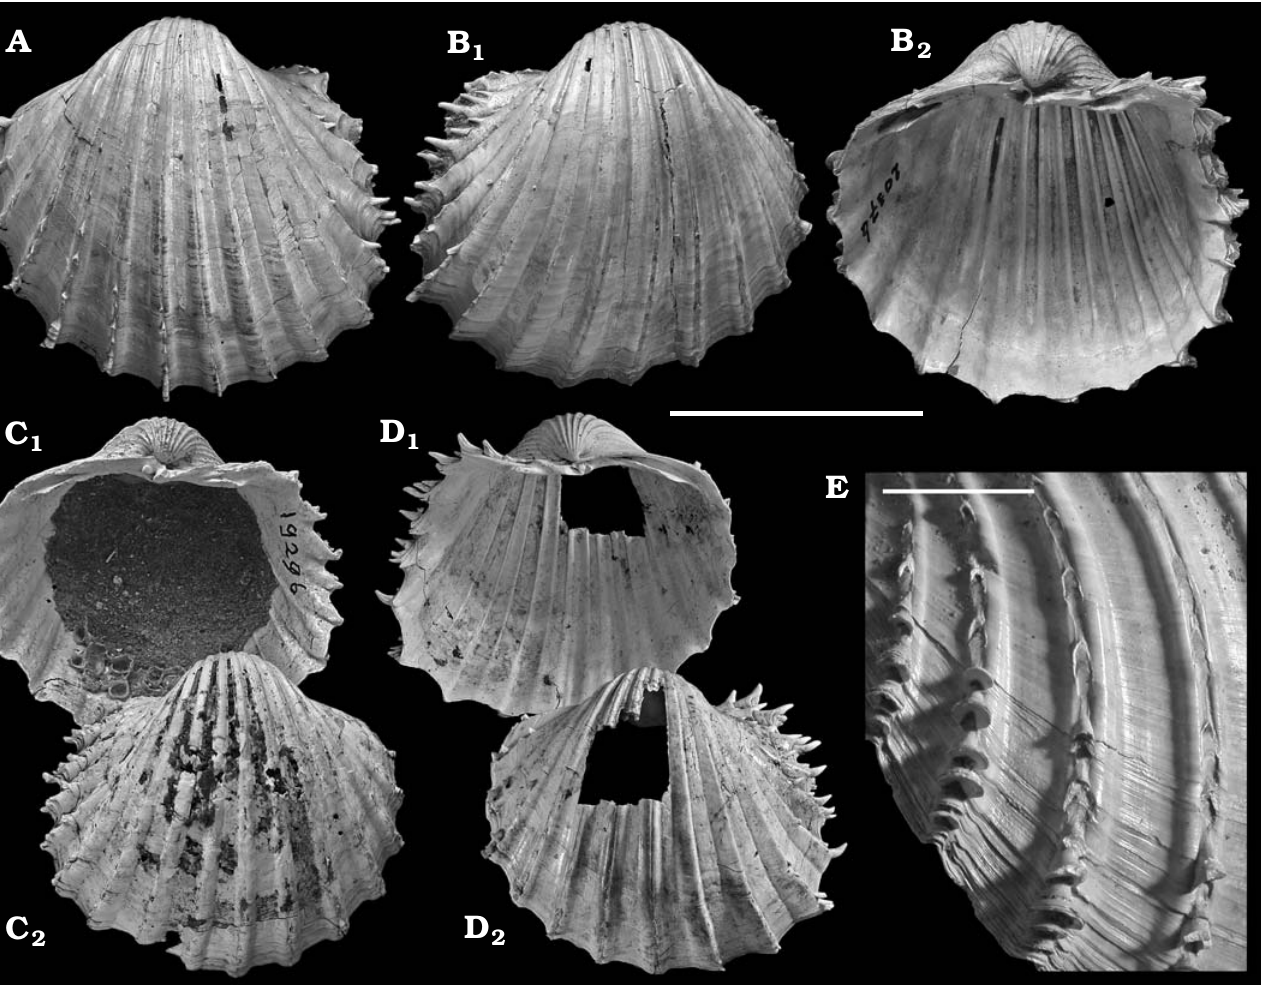
Fig. 6. Cardiid bivalve Procardium avisanense (Fontannes, 1879) from Tortonian (Miocene) of Cacela Velha, Portugal (A, B, E) and Serravallian (Miocene) of France, Salles, “Le Minoy”(C) and “l’Argileyre” (D). A . PH 20376, external view. B . PH 20376, external (B 1 ) and internal (B 2 ) views. C . PH 19296, internal (C 1 ) and external (C 2 ) views. D . RGM.794107.a, internal (D 1 ) and external (D 2 ) views. E . RGM.794104.c, detail of anterior sculpture. Scale bars: A–D, 50 mm; E, 10